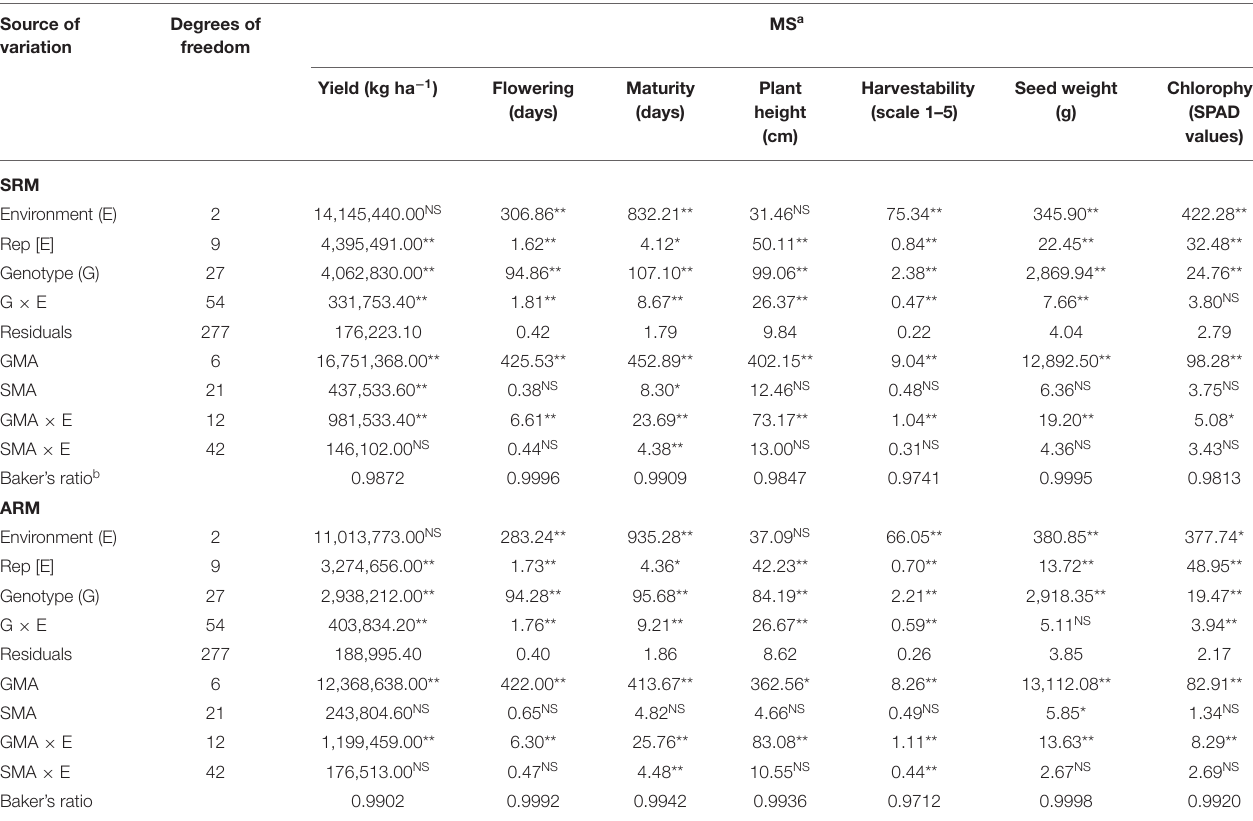
TABLE 4 | Analysis of variance for general mixing ability (GMA) and specific mixing ability (SMA) of the bean same row (SRM) and alternate rows (ARM) binary mixtures evaluated in three Ontario environments/locations in 2018. Source of